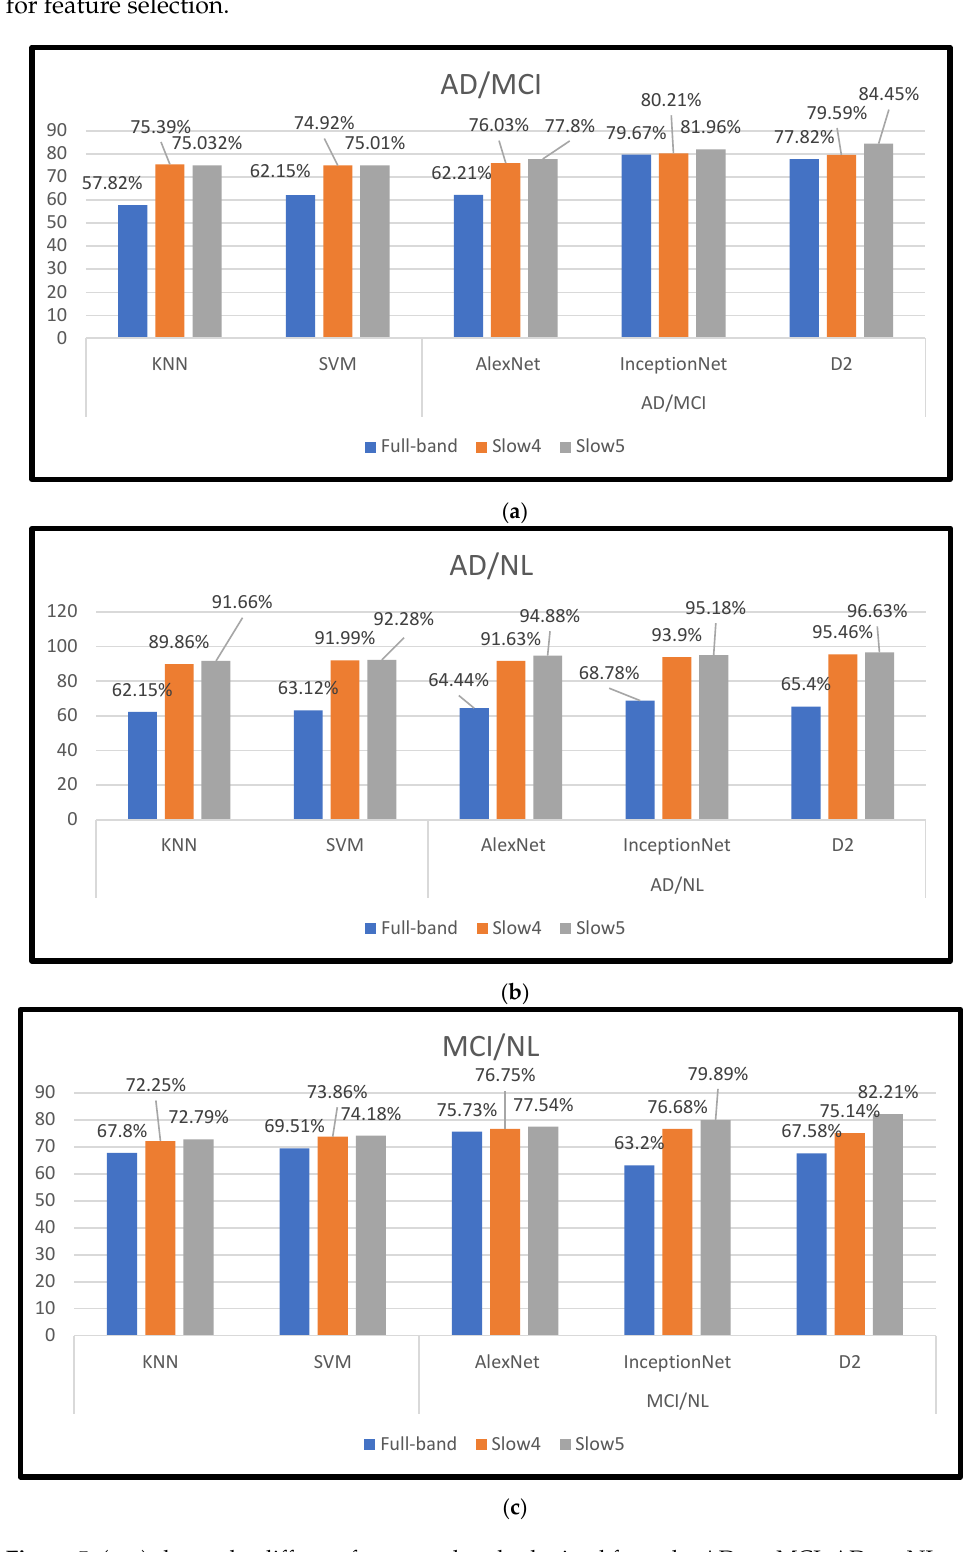
Figure 5. ( a – c ) shows the different frequency bands obtained from the AD vs. MCI, AD vs. NL, and MCI vs. NL.